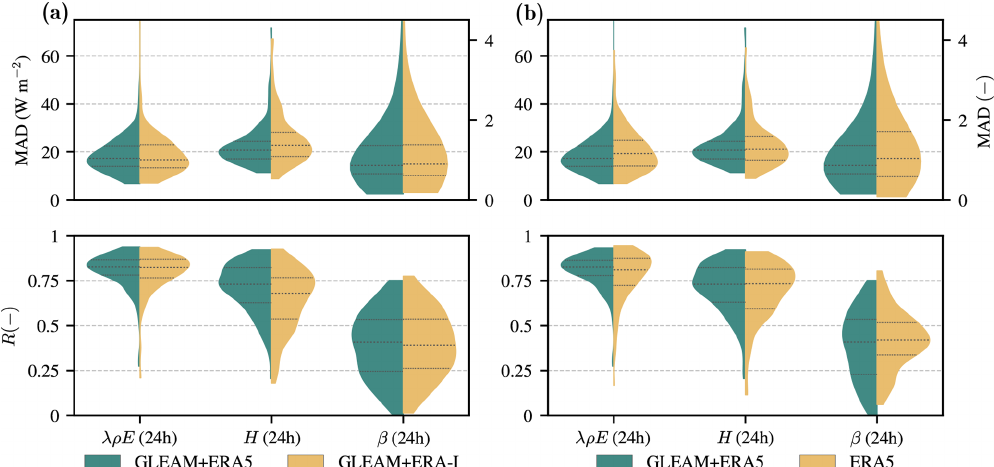
Figure A4. Violin plots of temporal validation statistics of the surface latent heat flux ( λρE ), surface sensible heat flux ( H ), and Bowen ratio ( β ) from GLEAM+ERA5, GLEAM+ERA-I, and ERA5. Panel (a) compares the violin plots from GLEAM+ERA5 and GLEAM+ERA-I and (b) directly compares the violin plots from GLEAM+ERA5 and ERA5. Statistics are calculated against in situ eddy-covariance measurements at daily temporal resolution. Violin plots represent the distribution of the individual validation statistics with indication of the median and interquartile range and are calculated using a kernel density estimation approach. Statistics include the MAD (raw in situ time series from 143 sites as reference) and R (raw in situ time series from 143 sites as reference). The distribution of the MAD of β is plotted on the right y